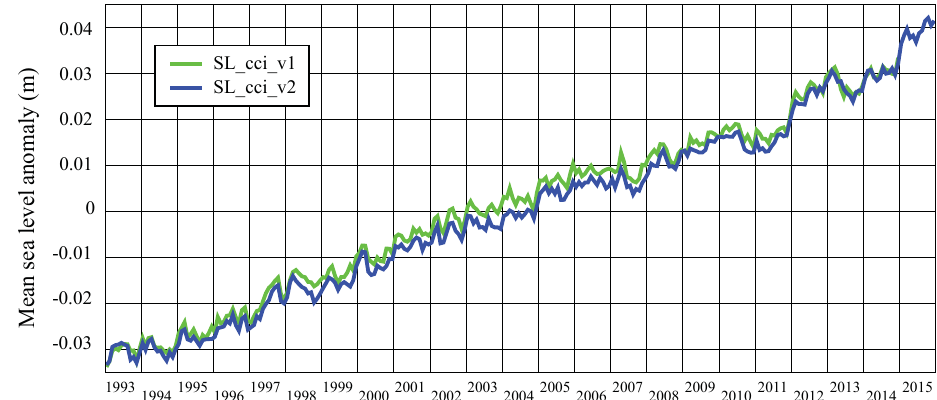
Figure 7. Comparison of time series of global mean sea level (seasonal signal removed). The v1.1 dataset had been updated until the end of 2014 and has a mean trend of 3.18mmyr − 1 ; v2.0, described in this paper, now extends to end of 2015 and has a trend of 3.21mmyr − 1 over the same period as